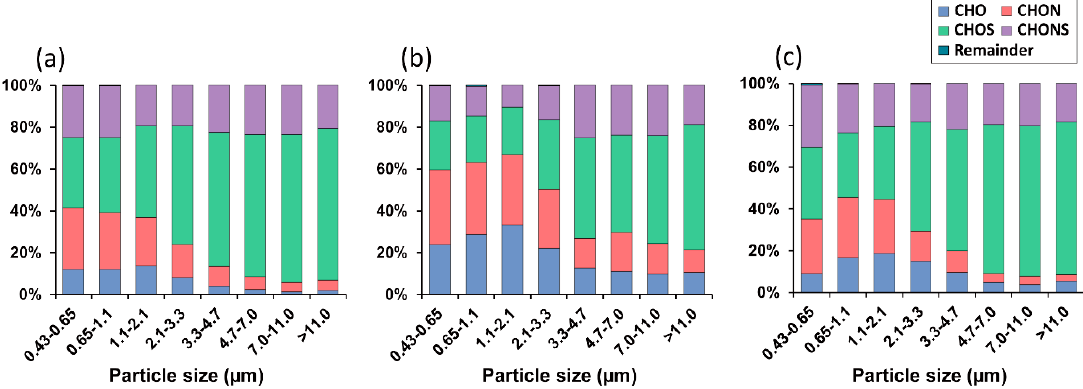
Figure 3. Size-segregated distributions of chemical classes of ambient aerosol-derived HULISs collected during the ( a ) preheating, ( b ) main-heating, and ( c ) postheating periods (color code: CHO, blue; nitrogen-containing CHO (CHON), red; sulfur-containing CHO (CHOS), green; nitrogen and sulfur-containing CHO (CHONS), purple; remainder, dark green).